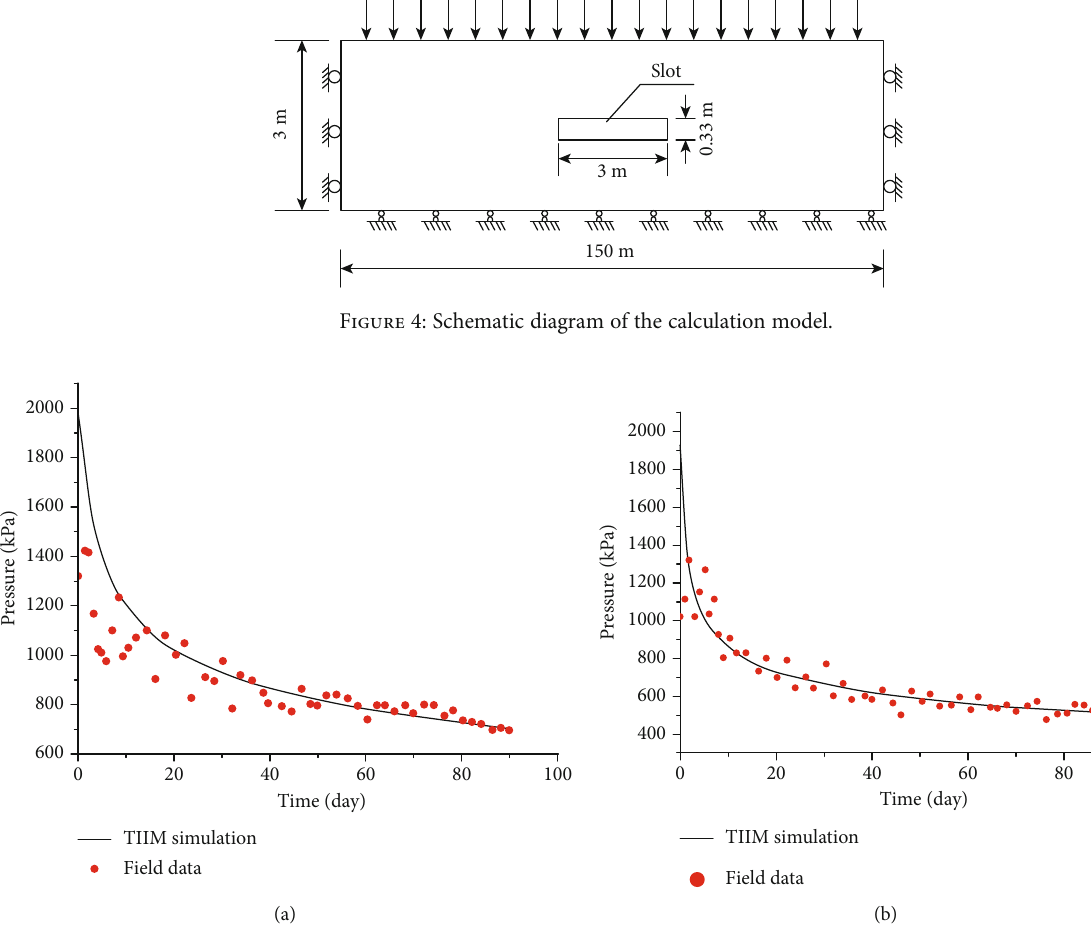
Figure 5: Field measurements and THM coupling model simulated methane pressures (a) for borehole #4 and (b) borehole #3. Red circles denote the fi eld measured data, and solid lines represent the model